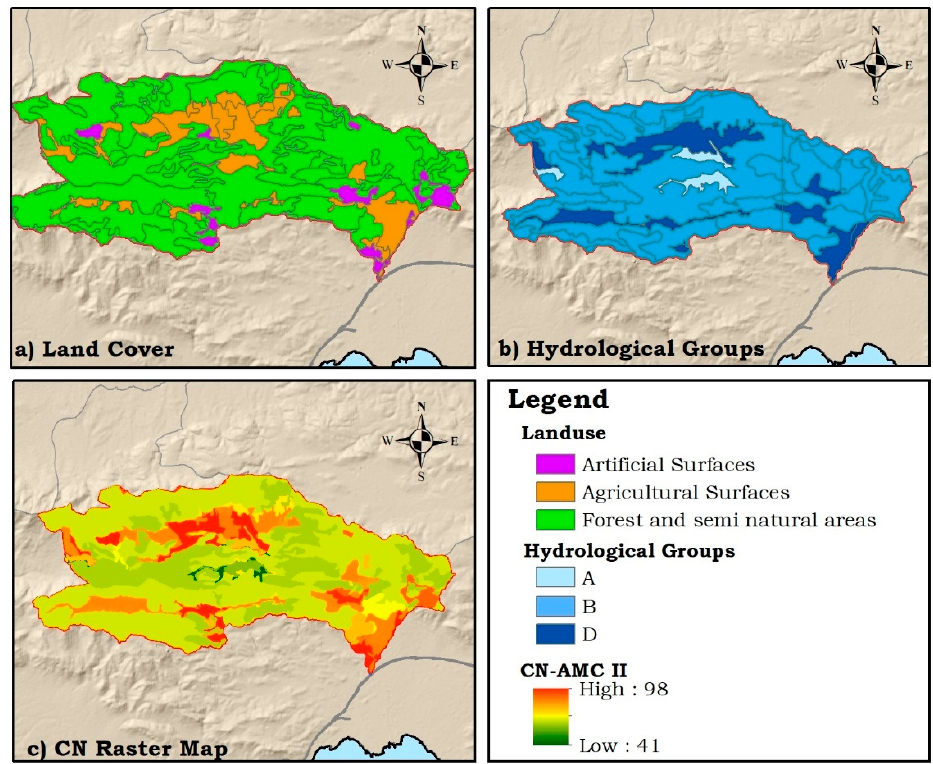
Figure 2. Geomorphological analysis—Curve Number (CN) map derivation process, ( a ) Corine Land Cover (CLC), classification level one, ( b ) hydrological groups, ( c ) CN raster map.